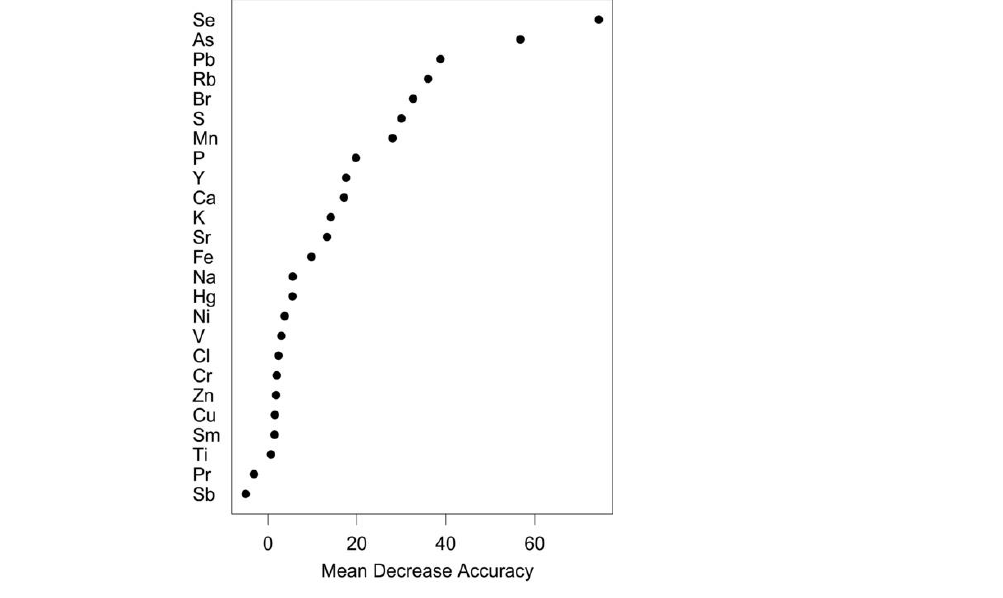
Figure 4. Importance of each element for the accuracy of the random forest classifications, according to the mean decrease in the accuracy measure, based on the elemental fingerprints of the muscle of Sparus aurata collected at the following four sampling origins. Olhão – wild (Owild), Olhão – aquaculture in earth ponds (Opond), Olhão – sea-cage aquaculture (Ocage), Madeira – sea-cage aquaculture (Mcage). Table 3. Classification accuracy (by production method) of random forest classifications based on the elemental fingerprints of Sparus aurata collected at Olhão (model training), and the allocation of the samples from Madeira Island in the origins of the training model (test). Olhão – wild (Owild), Olhão – aquaculture in earth ponds (Opond), Olhão – sea-cage aquaculture (Ocage) and Madeira – sea- cage aquaculture (Mcage).